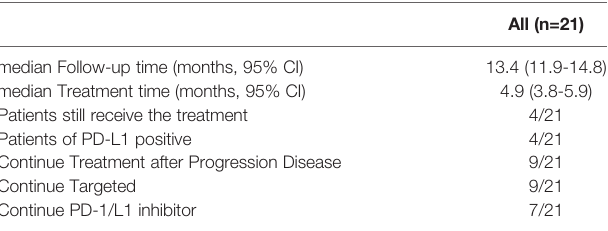
TABLE 3 | Clinical characters of BTC patients treated with Apatinib plus Camrelizumab.